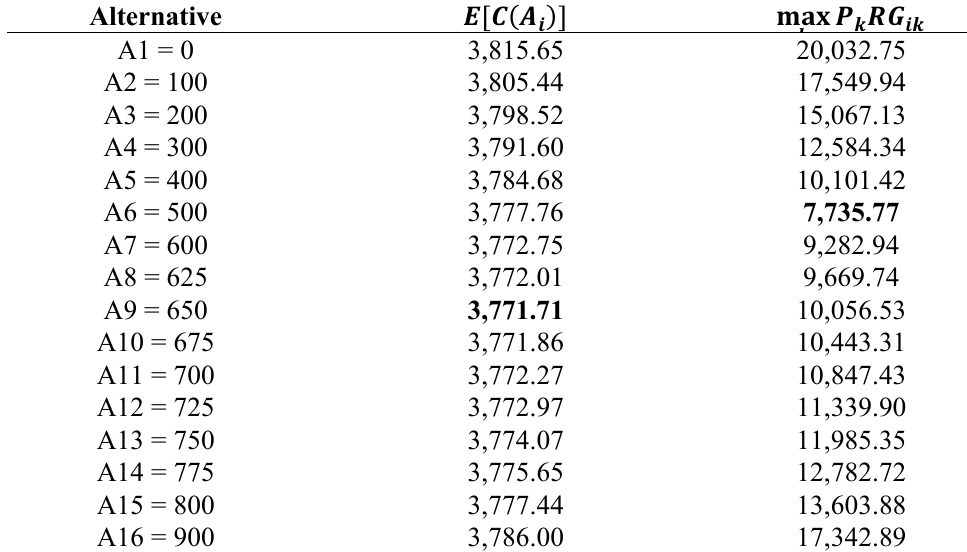
Table 6. Expected value of the costs (k$) and maximum weighted regret ($) of each alternative—Case